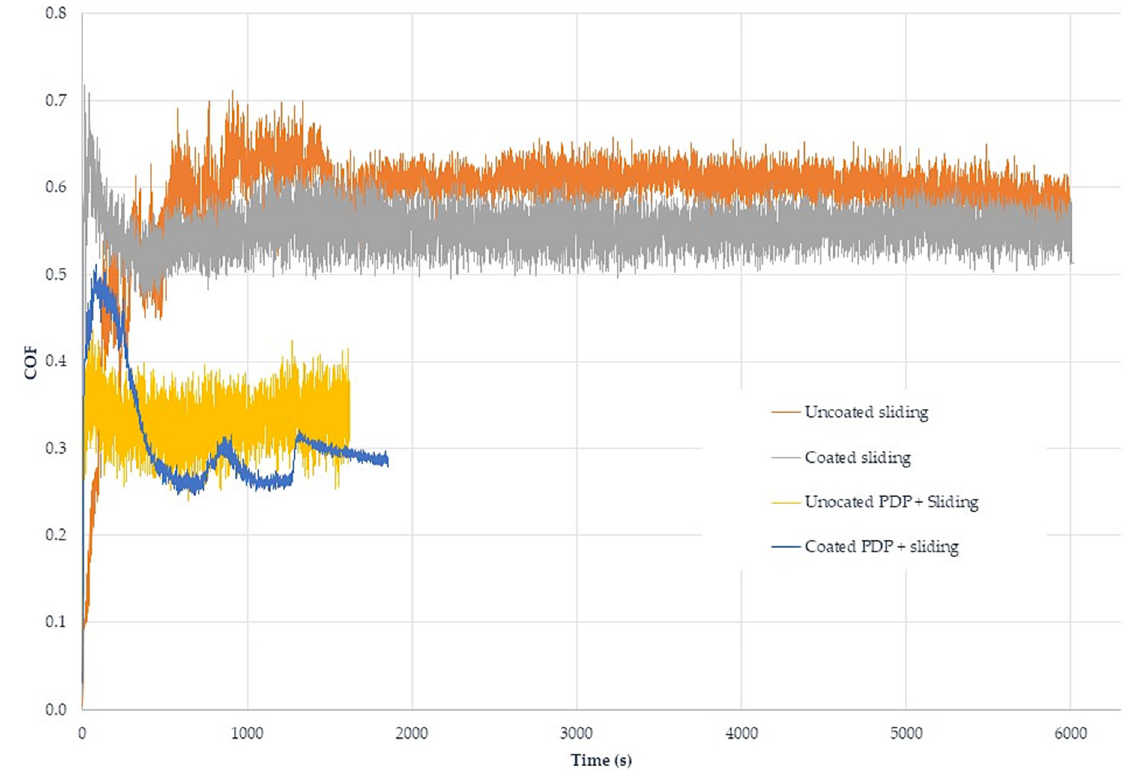
Figure 8. Friction coefficient of coated and uncoated simples in dry conditions and in combinate tests of PDP and sliding.